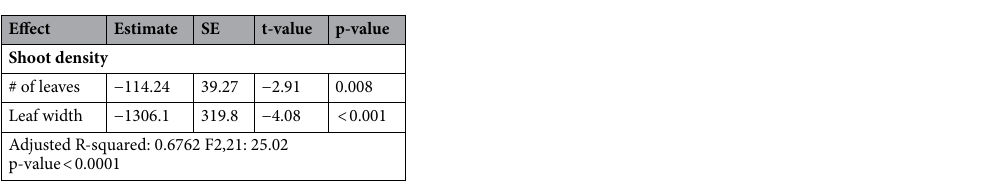
Table 3. Multiple regression output of Posidonia oceanica shoot density against the predictors retained in the model by the backward selection.